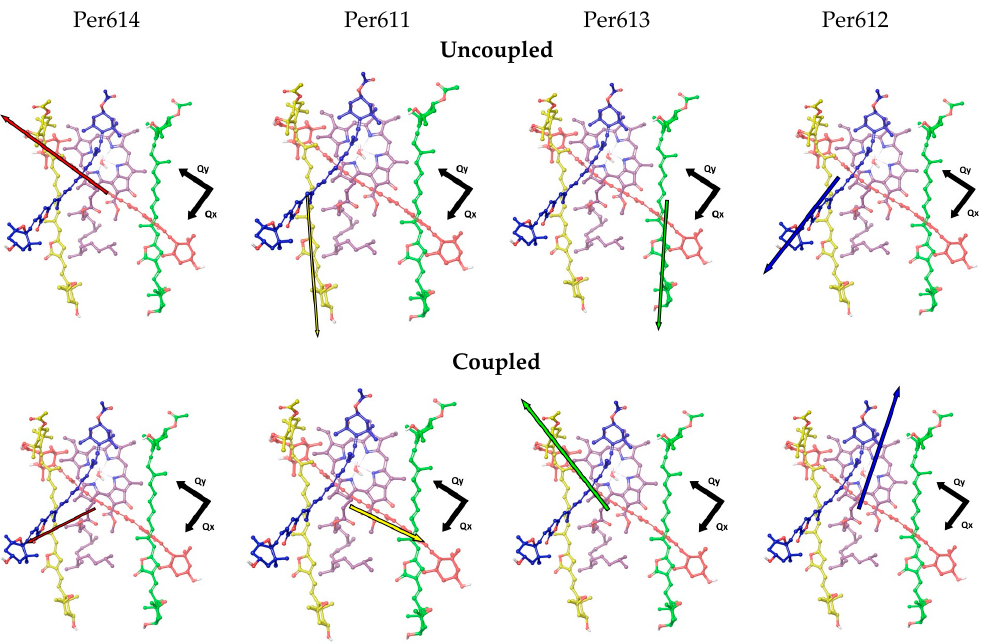
Figure 2. Visualization of the S 0 → S 2 TDMs for (top panel) uncoupled and (bottom panel) coupled Pers in a functional domain of PCP. The coupled states are assigned to the Per that carries at least